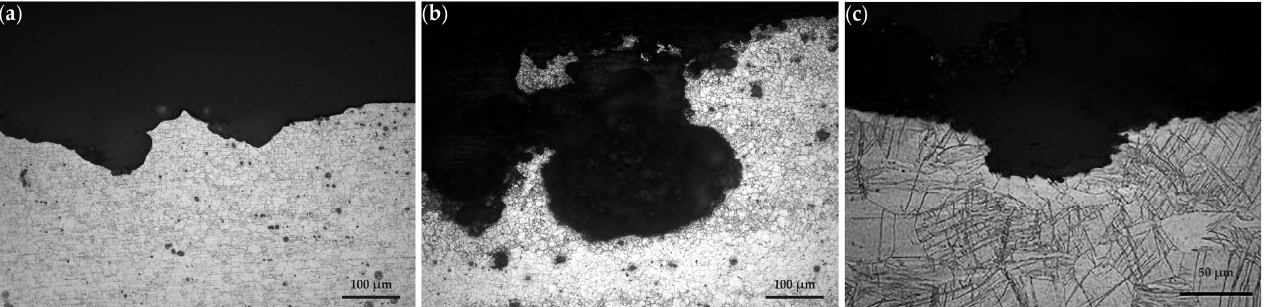
Figure 10. Typical metallographic sections in the longitudinal (L) directions of: ( a ) AZ31 specimen tested for 6 h; ( b ) AZ61 specimen tested also for 6 h; and ( c ) WE43-T5 specimen tested for 24 h.